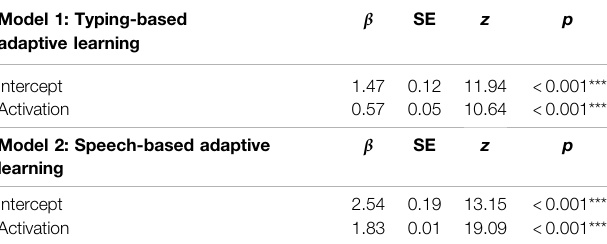
TABLE 1 | Predicting accuracy from reaction time-based memory activation. Model 1: Typing-based adaptive learning